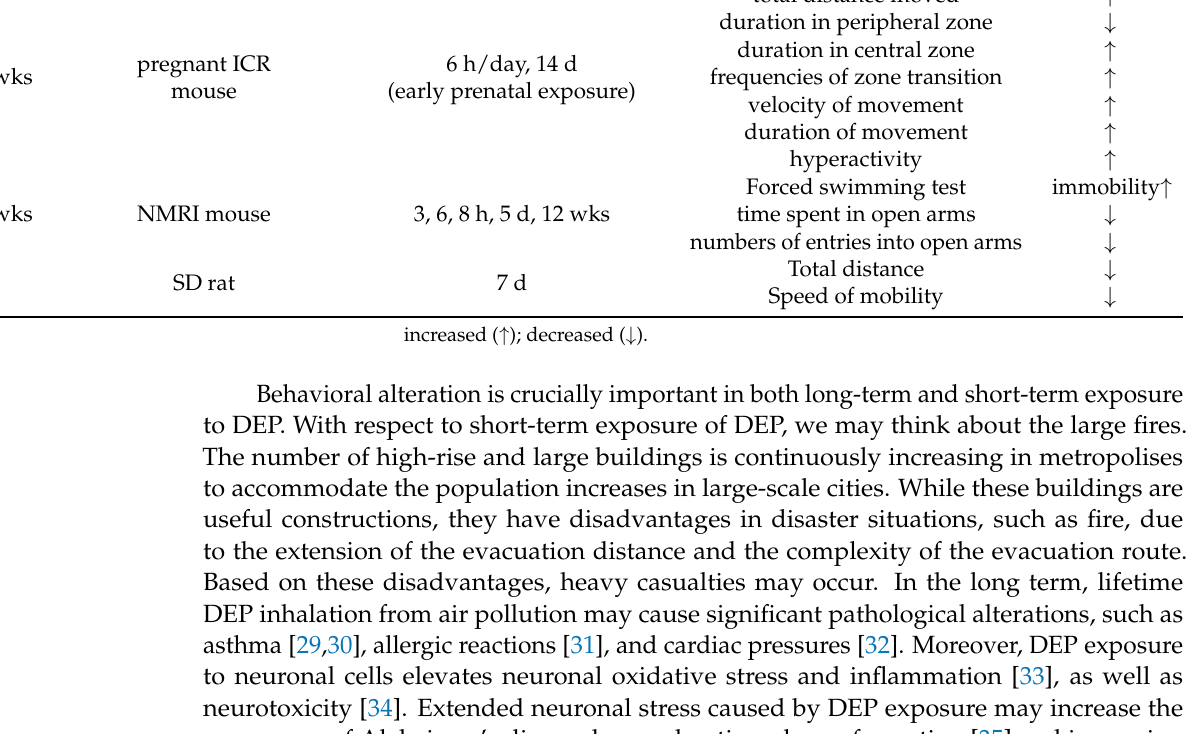
Table 3. Selected behavioral studies after particulate matter (PM) exposure by behavior test.